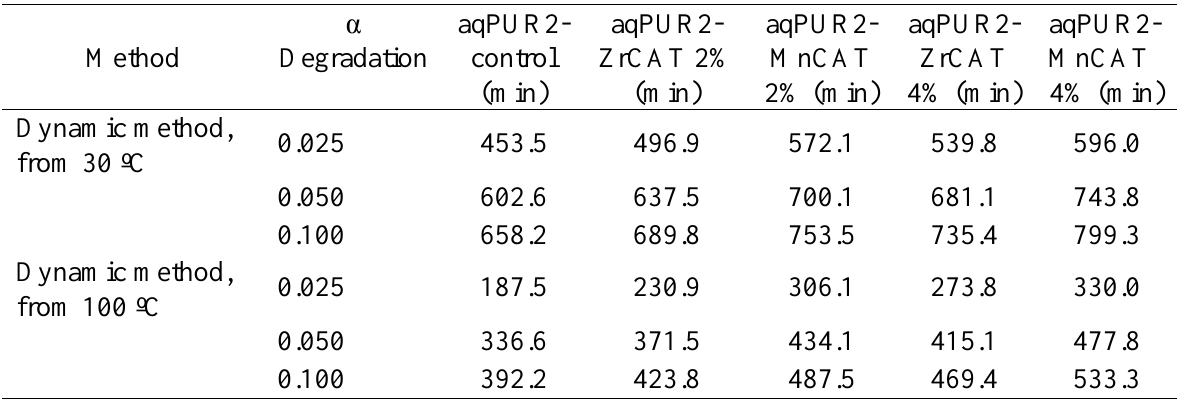
Table 6 . The total time of the decomposition required to calculate the thermal stability of the sample aqPUR2 at various degrees of the